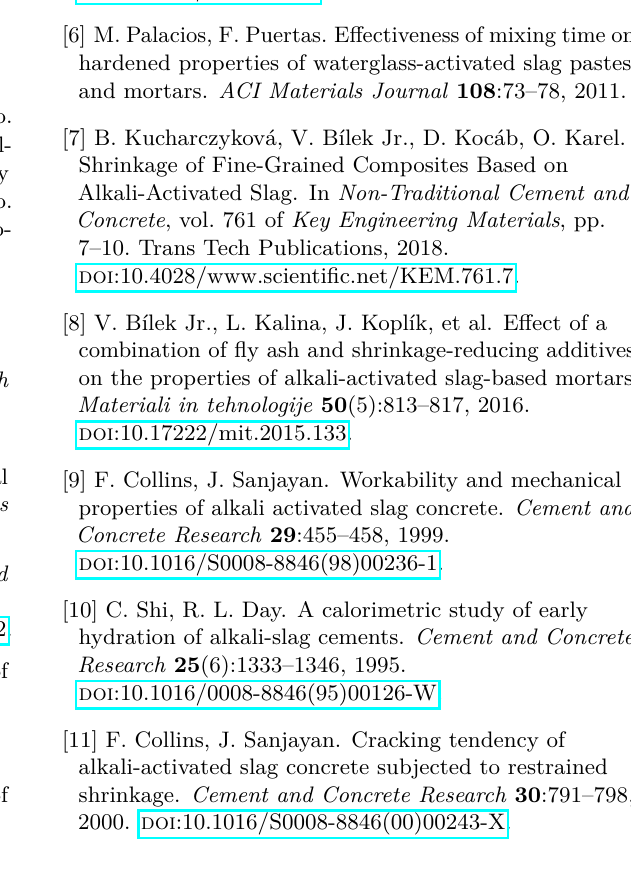
and the shear modulus G crf